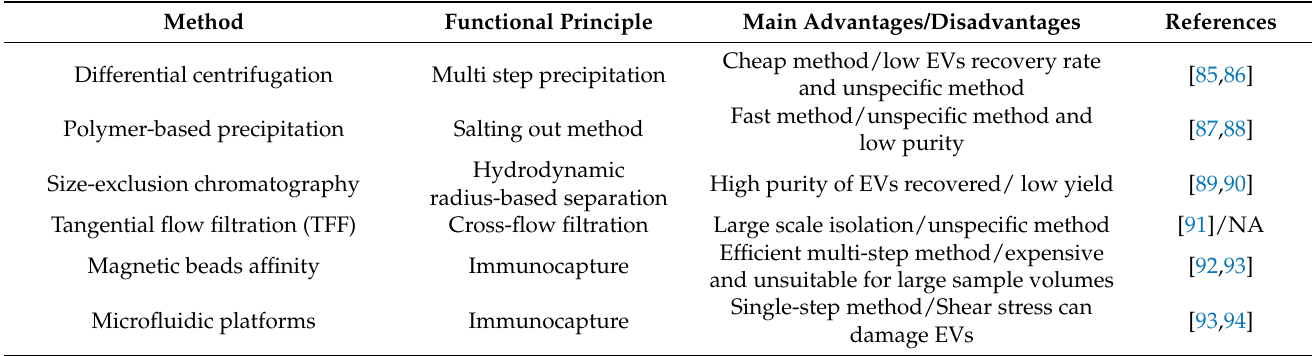
Table 1. Main extracellular vesicles’ isolation and purification